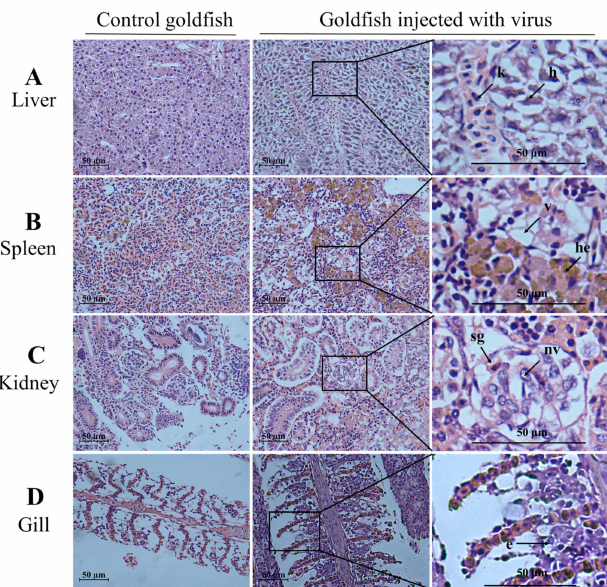
Figure 6. Histological changes in the liver, spleen, kidney, and gill from challenged goldfish (HE staining). Scale bars = 50 µ m. ( A ) Extensive necrosis of liver parenchyma. Karyopyknosis (k) and hyperemia (h) marked by an arrow; ( B ) vacuolation of cytoplasm (v) and hemosiderosis (he) in spleen; ( C ) the arrow shows the swelling of glomerular (sg) and nuclear vacuole (nv); ( D ) exfoliation of epithelial cells (e) marked by an arrow.